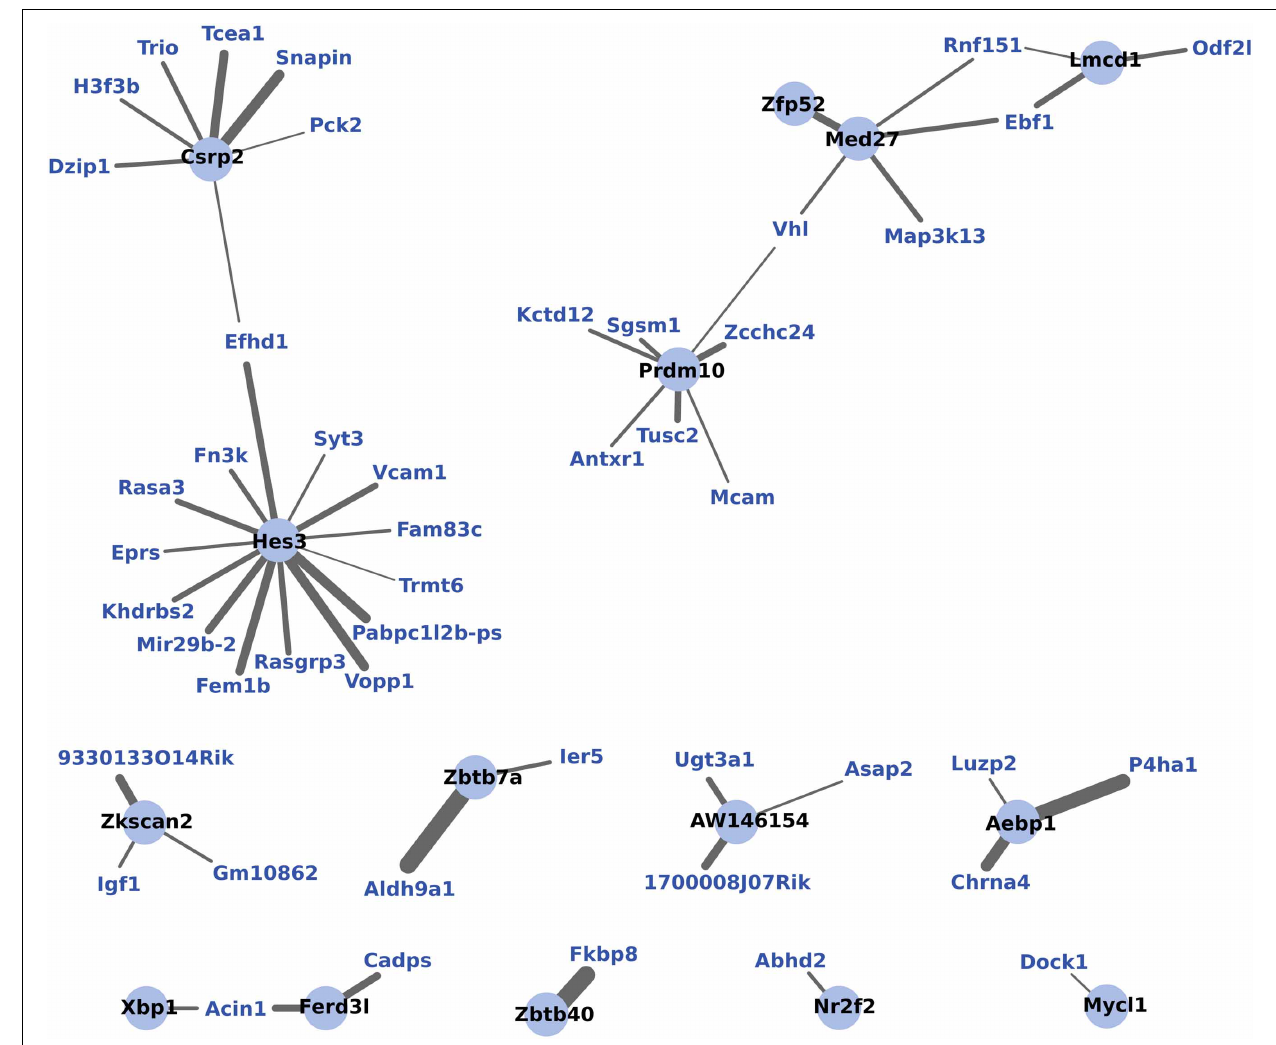
FIGURE 5 | WGCNAnetworkoftranscriptionfactorsandgeneswithhighly correlated expression changes in maternal mPFC. Within the gene module identified by WGCNA as having highly correlated expression, transcription